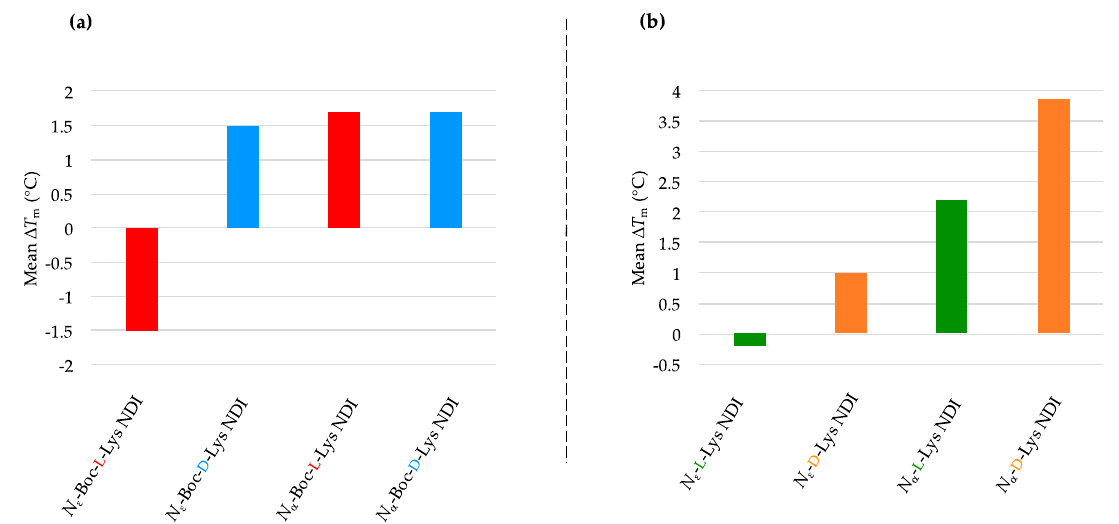
Figure 4. Graphical representations of mean Δ T m values obtained from VT CD studies of c-KIT1 with 10 equivalents of ( a ) N α - and N ε -Boc- L - and D -NDIs as well as ( b ) N α - and N ε - L - and D -NDIs. Table 2. The T m values of c-KIT1 only compared to the T m of ( a ) c-KIT1-Boc-protected-NDIs and ( b ) c-KIT1-deprotected-NDIs as determined from VT CD studies.